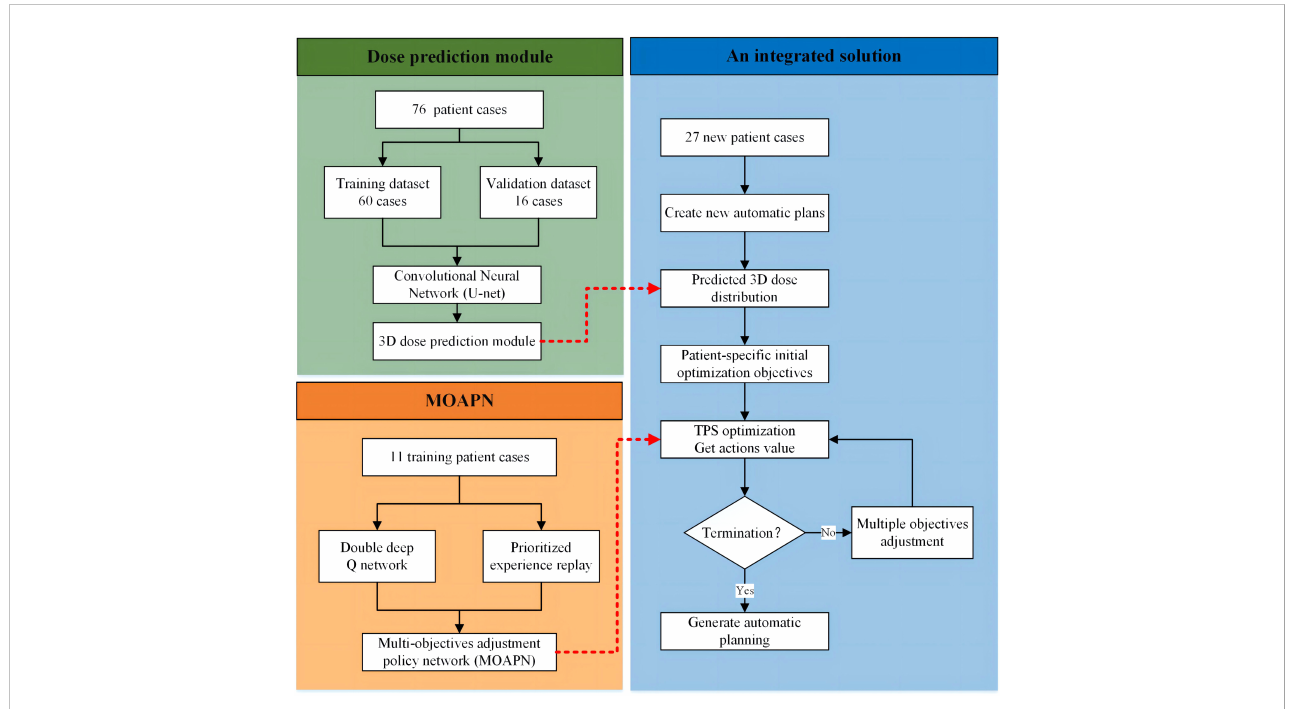
FIGURE 1 The overall work fl ow of an integrated solution for automatic treatment